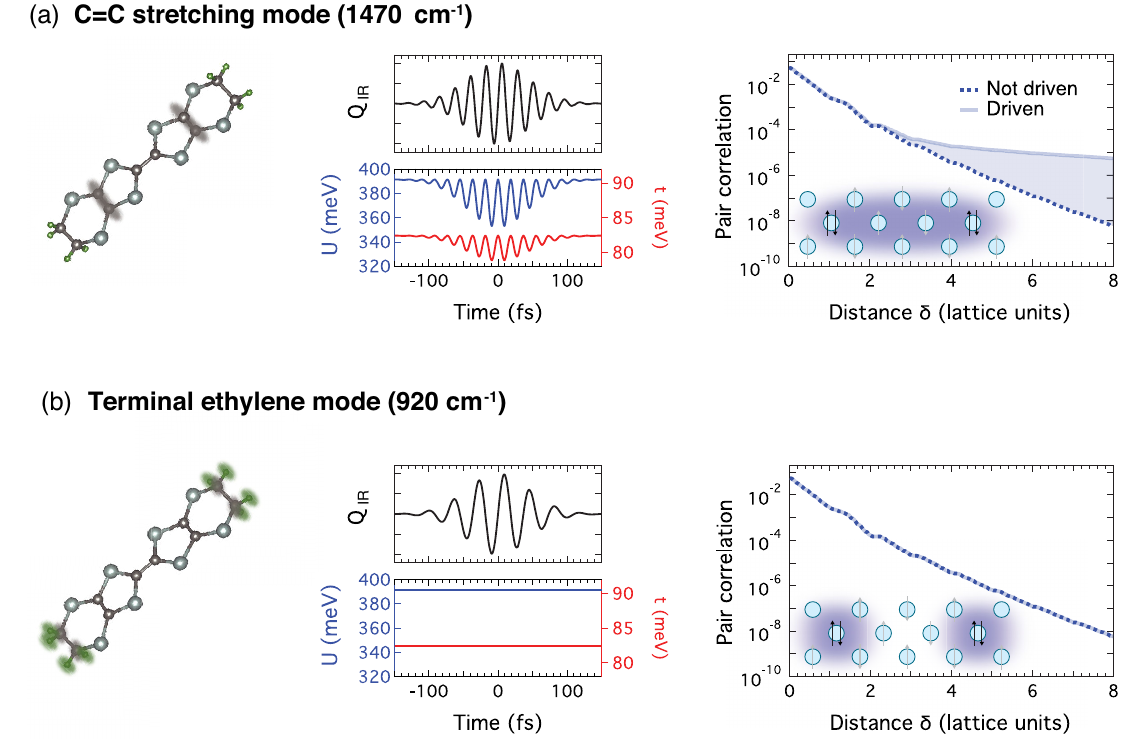
FIG. 7. Left panels: Atomic motions corresponding to the 1470 cm − 1 (a) and 920 cm − 1 (b) modes of the ET molecule. Center panels: Time-dependent displacement along the normal coordinates and induced modulations of the on-site Hubbard U interaction and hopping matrix element t , calculated with ab initio simulations in the frozen-phonon approximation for the two different driven modes. Right panels: Corresponding spatial evolution of the pair correlation function, calculated with a time-dependent triangular ladder Fermi- Hubbard model in the undriven case (blue dashed line) and driven case (blue solid lines) for the two modes. The insets display a schematic representation of the correlation between pairs on different